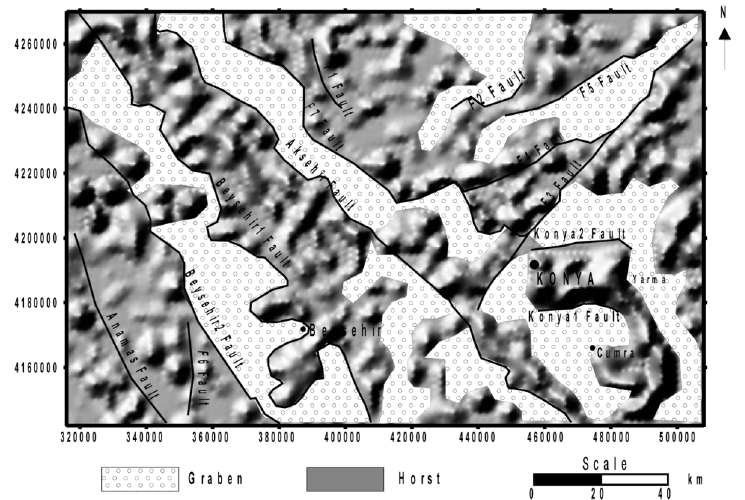
Fig. 11. Proposed tectonic map of the studied